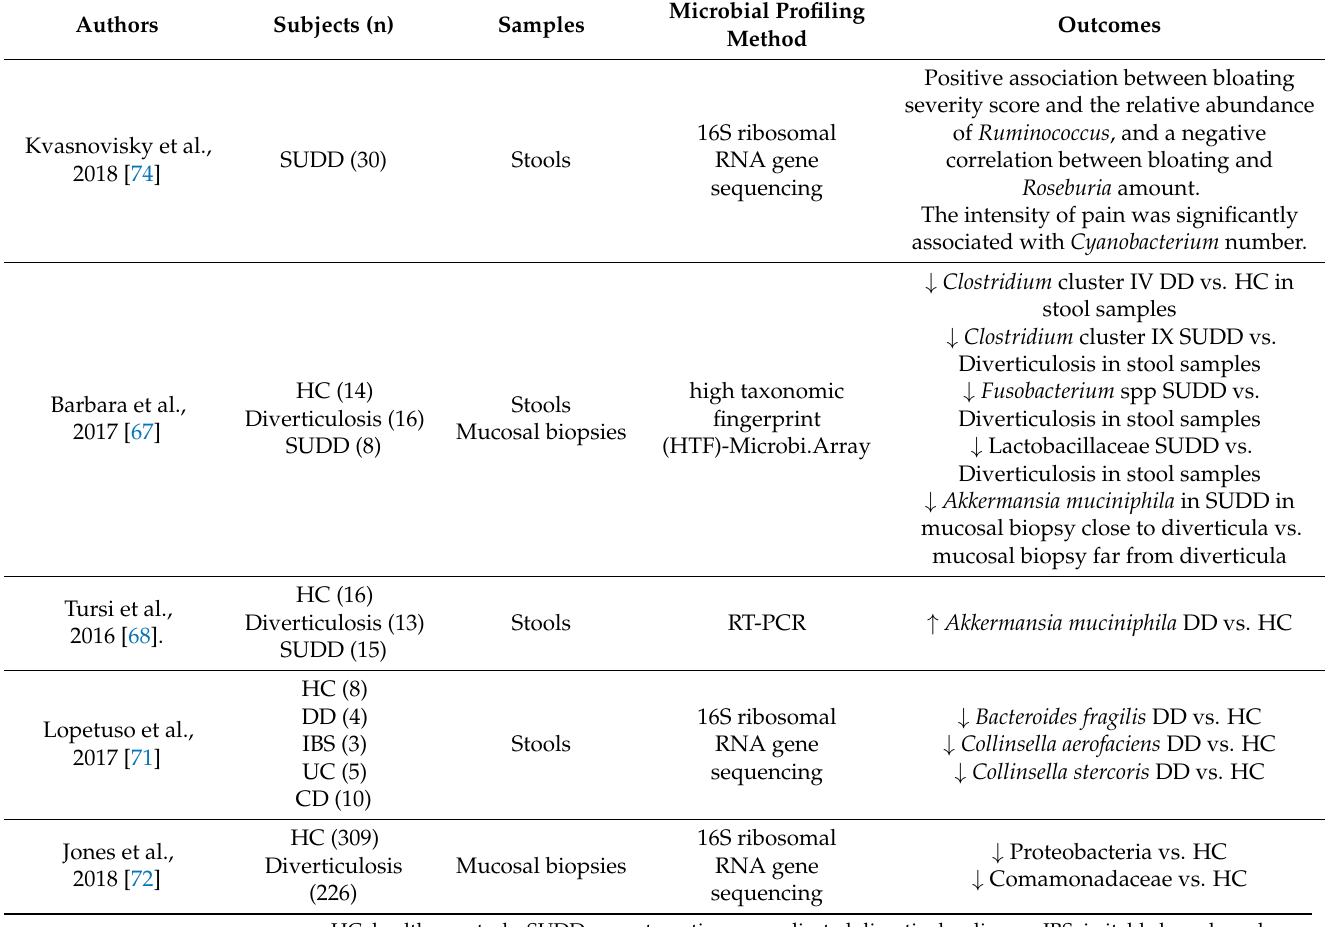
Table 3. Main studies assessing gut microbiota in